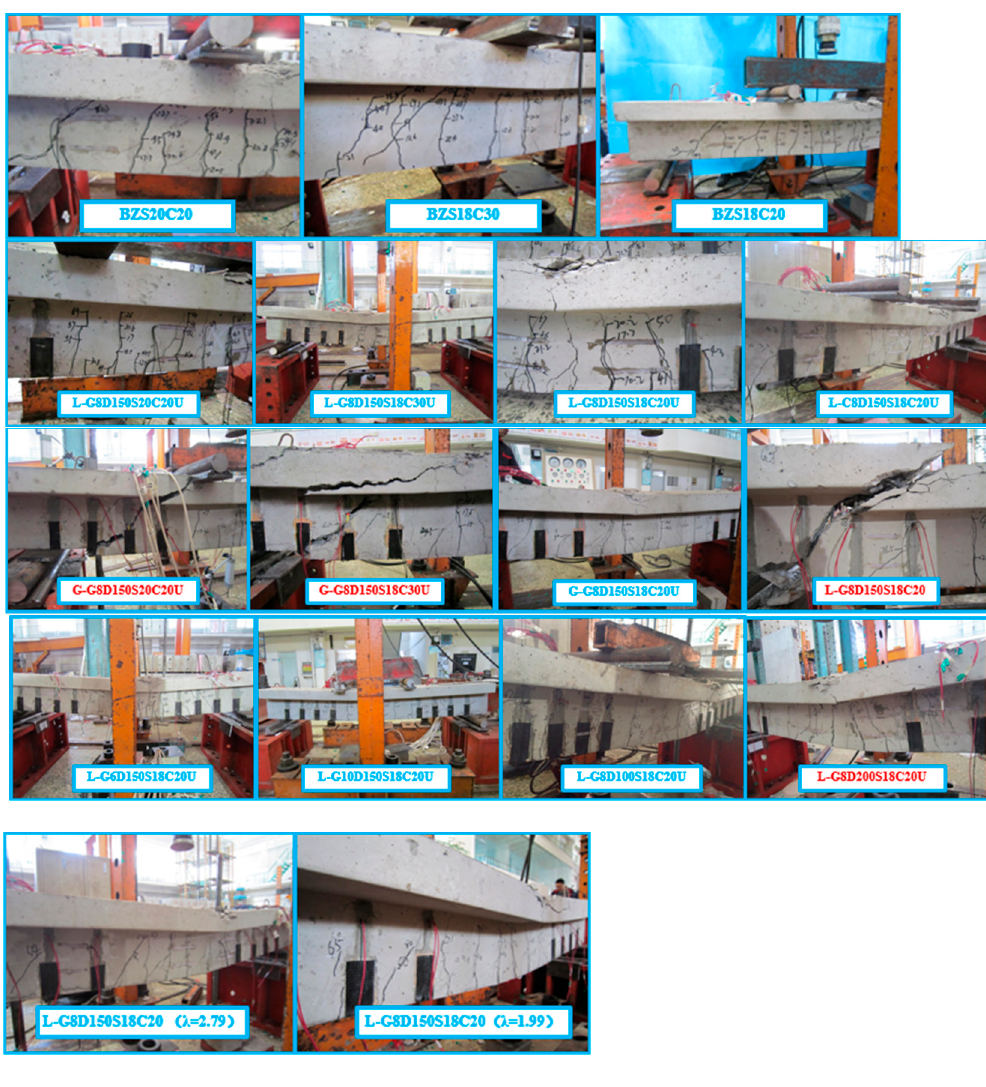
Figure 5. Typical failure mode. Table 6. Failure modes of specimens.